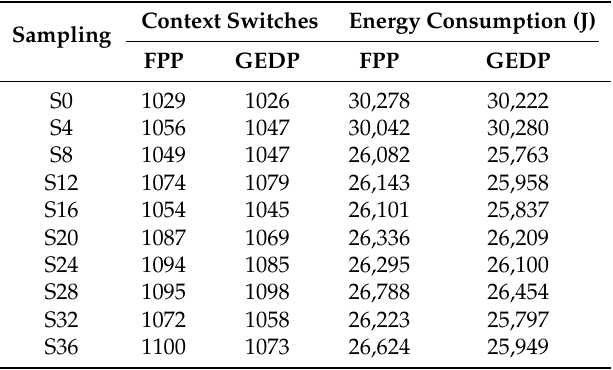
Table 4. System energy consumption